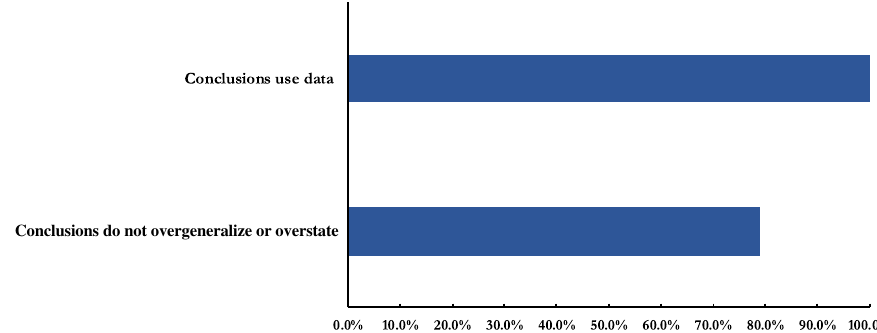
FIG. 5. Percentage of manuscripts that used data in the conclusions and conclusions did not overgeneralize or overstate.